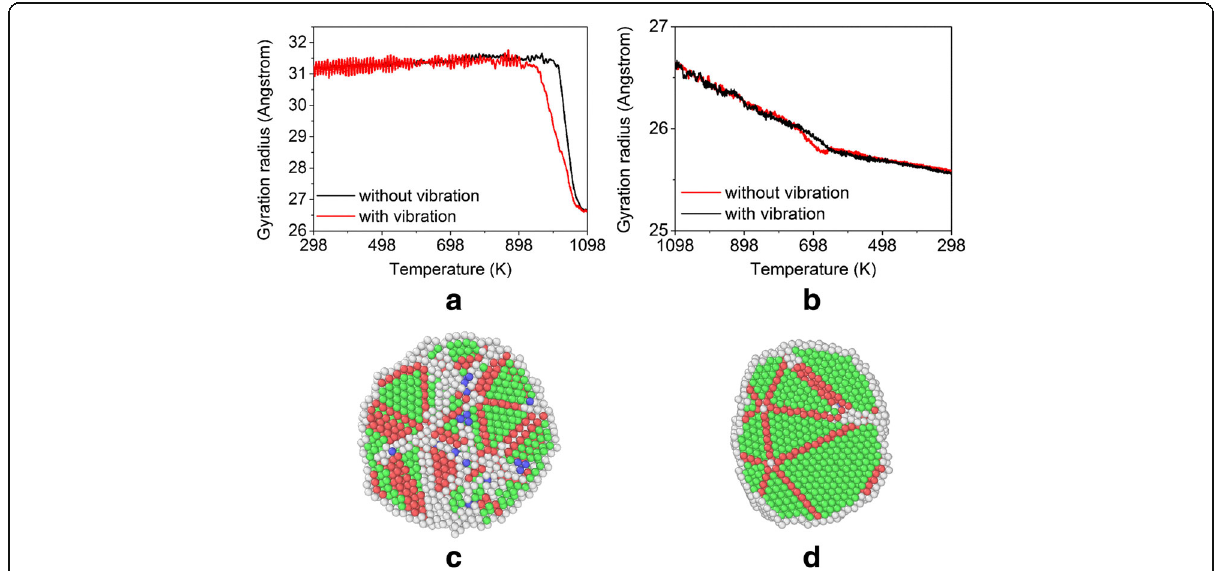
Fig. 8 Influence of the environmental vibration. a , b Gyration radius as a function of temperature during the heating and cooling processes with and without system vibration. c , d Nanostructures of the sintered silver nanoparticles without vibration and with vibration, respectively